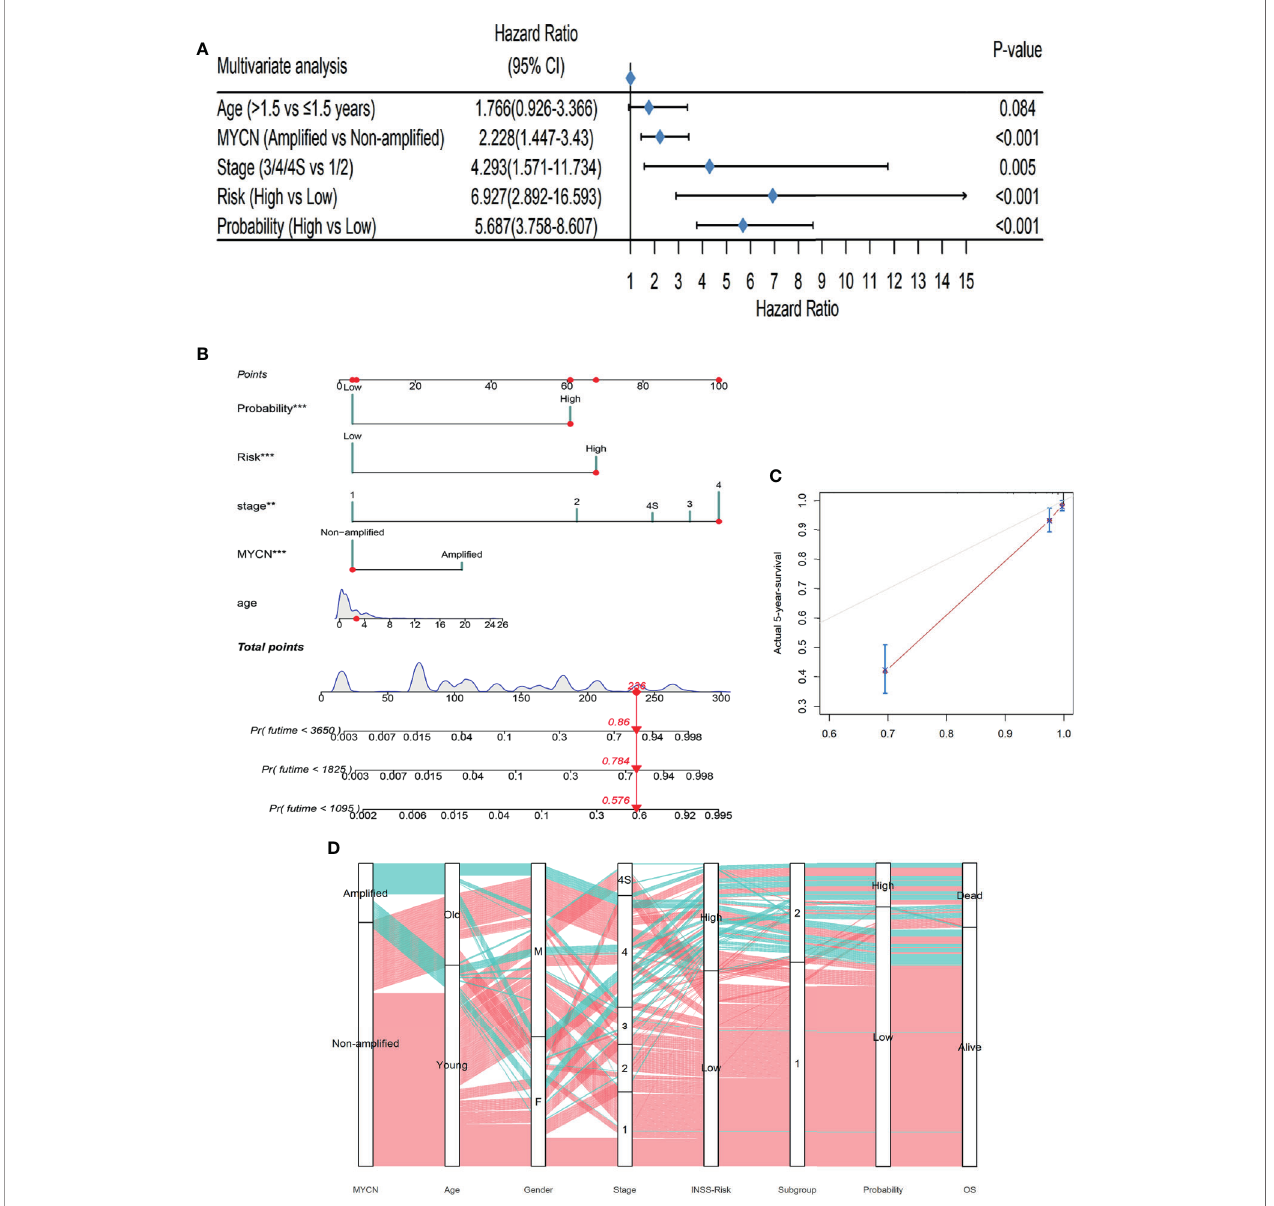
FIGURE 5 | The DL-model was independent of clinical covariates and could aid to diagnose. (A) The DL output probability was signi fi cant in the multivariable cox regression with clinical covariates ( p < 0.001). (B) A nomogram could be bene fi cial for survival time prediction. (C) The calibration curve of the nomogram with a C -index: 0.889. (D) The alluvial diagram visualized the general conditions of patients. Coralline lines represented patients without MYCN ampli fi ed and atroceruleous lines represented those with MYCN ampli fi